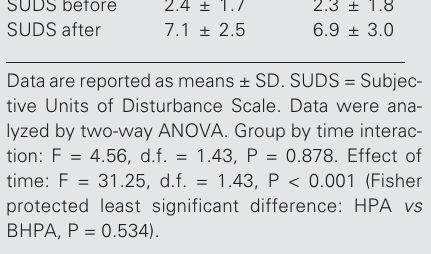
Table 2. Subjective anxiety levels just before and after hyperventilating in the hyperventilation-sen- sitive panic attack group (HPA) vs the breath- holding-sensitive panic attack group (BHPA) just before and after breath holding. Self-rating